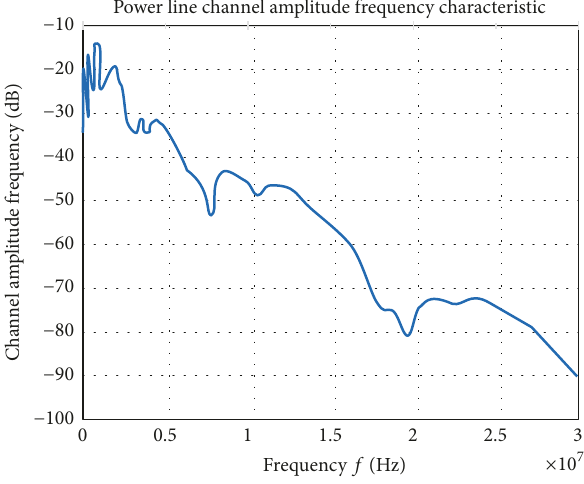
Figure 8: Amplitude frequency response of reference